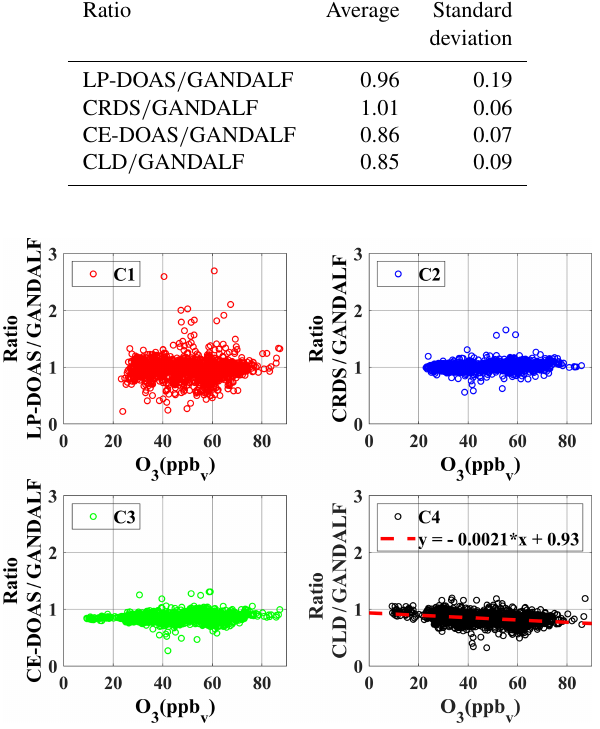
Figure 12. Ratios as a function of ambient O 3 during PARADE.